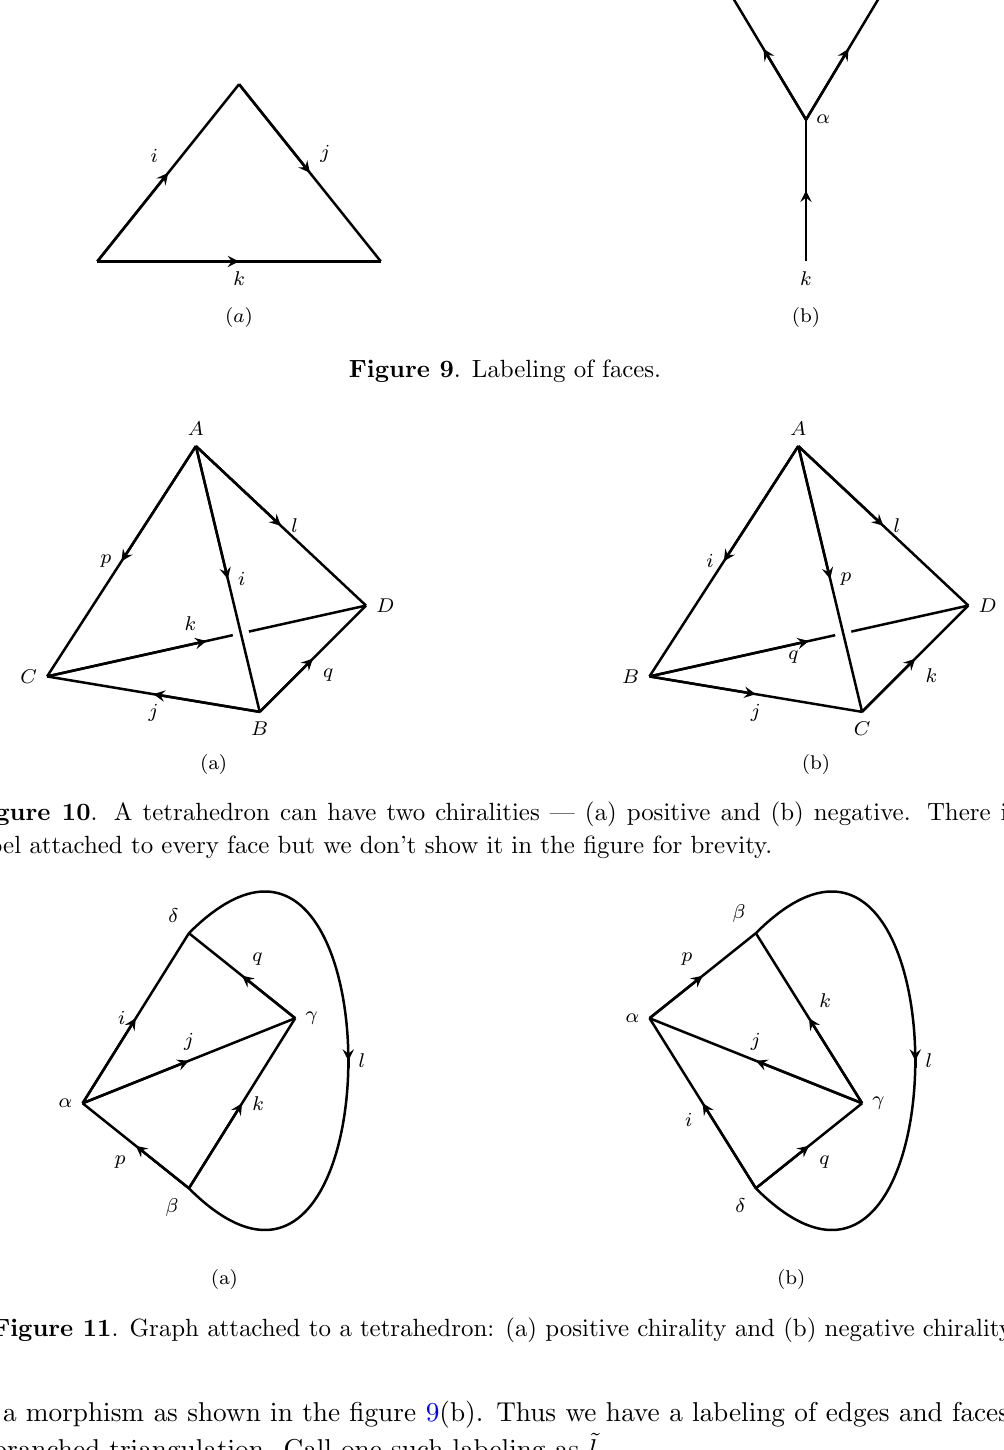
Figure 9 . Labeling of faces.